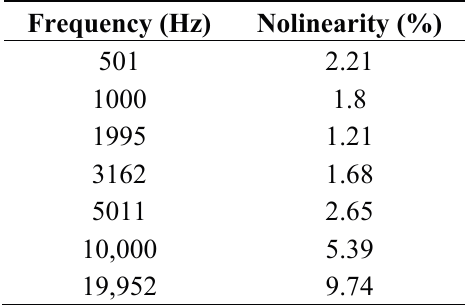
Table 1. Non-linearity results presented in Figure 7b.